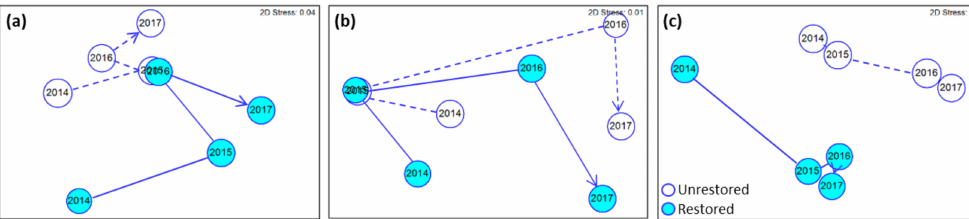
Figure 4. Non-metric multidimensional scaling of reach centroids averaged across all sites for ( a ) particle-associated microbes, ( b ) planktonic microbes, and ( c ) invertebrates. Lines represent direction of change by year; circles are proportional to within-group multivariate dispersion (i.e., mean distance of individual samples to the centroid). Microbial composition is standardized log transformed OTU abundances and invertebrates fourth root-transformed numerical